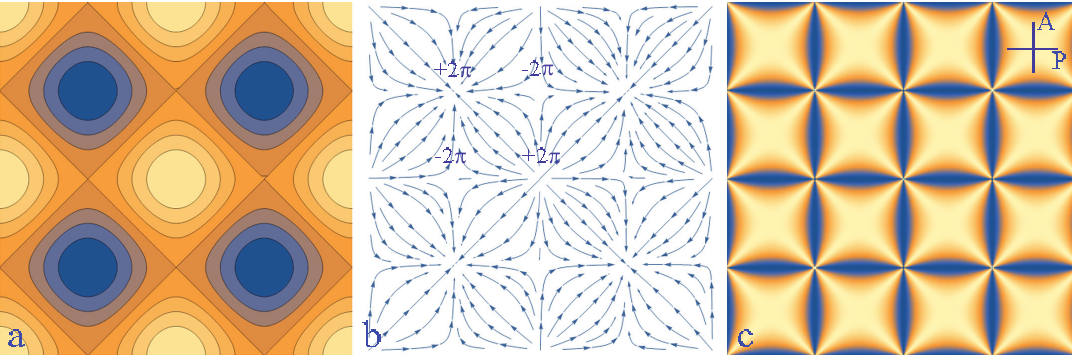
Figure 15. Gadanken experiment: stabilisation of a dowsons pattern by tropisms of the dowser texture. a) Topography of the gap thickness h(x,y) or of the electric potential U(x,y). b) Dowser field d oriented by the corresponding thickness gradient g = U . c) Pattern of isogyres seen in polarising microscope. E = ∇